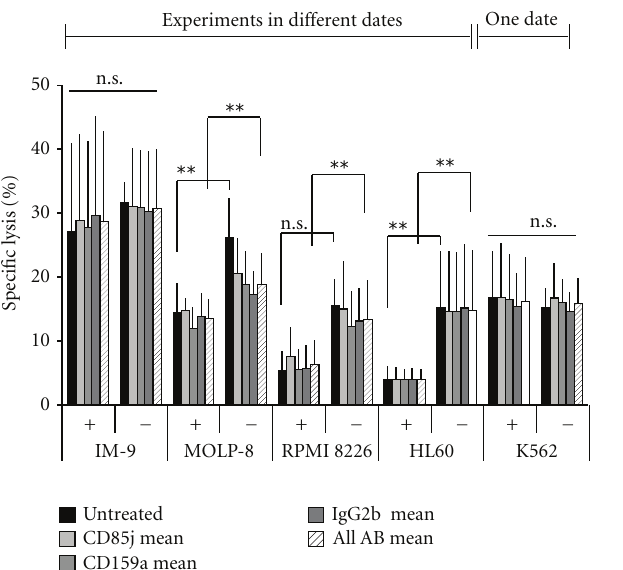
Figure 7: Blocking of LIR-1 and HLA on tumor cells does not lead to increased lysis by NK-92 cells. LIR-1 (CD85j) and HLA class I molecules of the tumor cell lines were blocked as before on the NK- 92 cells. After incubation and extended washing, standard CRA were performed. Neither LIR-1 nor HLA blocking showed significant increase of tumor cell lysis. All experiments were performed with the use of F(ab (cid:3) ) 2 to prevent ADCC. Statistical analysis performed by ANOVA excluded any significant e ff ect of either isotype or Ab on target cell lysis, compared to untreated samples. Discrete investigation of K562 treatment, performed as a comparison of cumulated values for all Ab-incubated samples with or without F(ab (cid:3) ) 2 , excluded any influence of additional F(ab (cid:3) ) 2 on the results ( P = 0 .